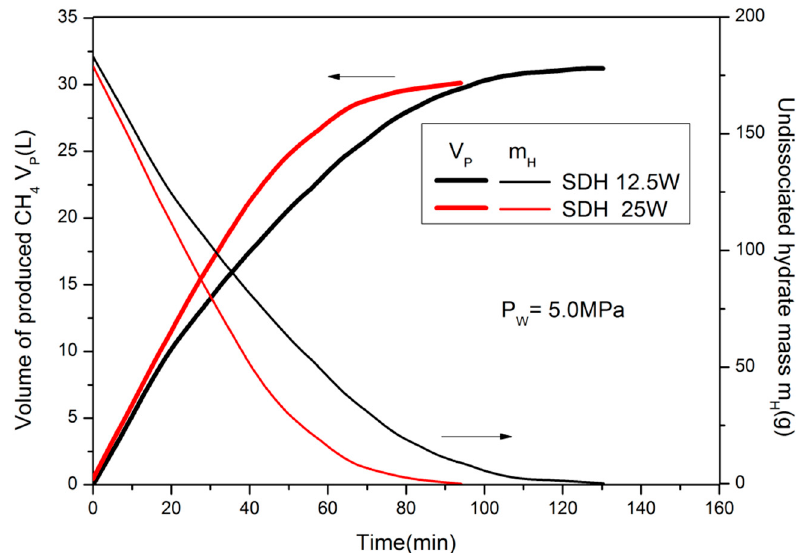
Figure 6. Cumulative gas production ( V P ) and undecomposed hydrate mass ( m H ) under different electric heating power.